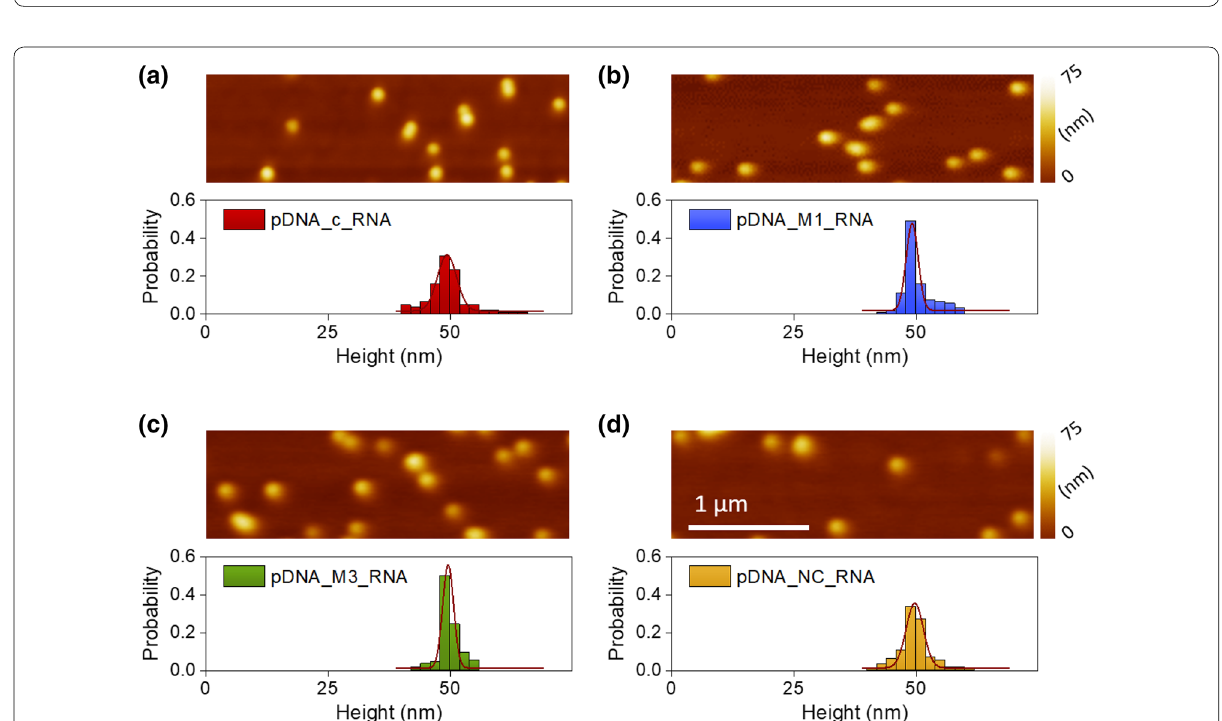
Fig. 3 a – d Topography images and Gaussian distribution of the DCNPs: a pDNA pDNA +